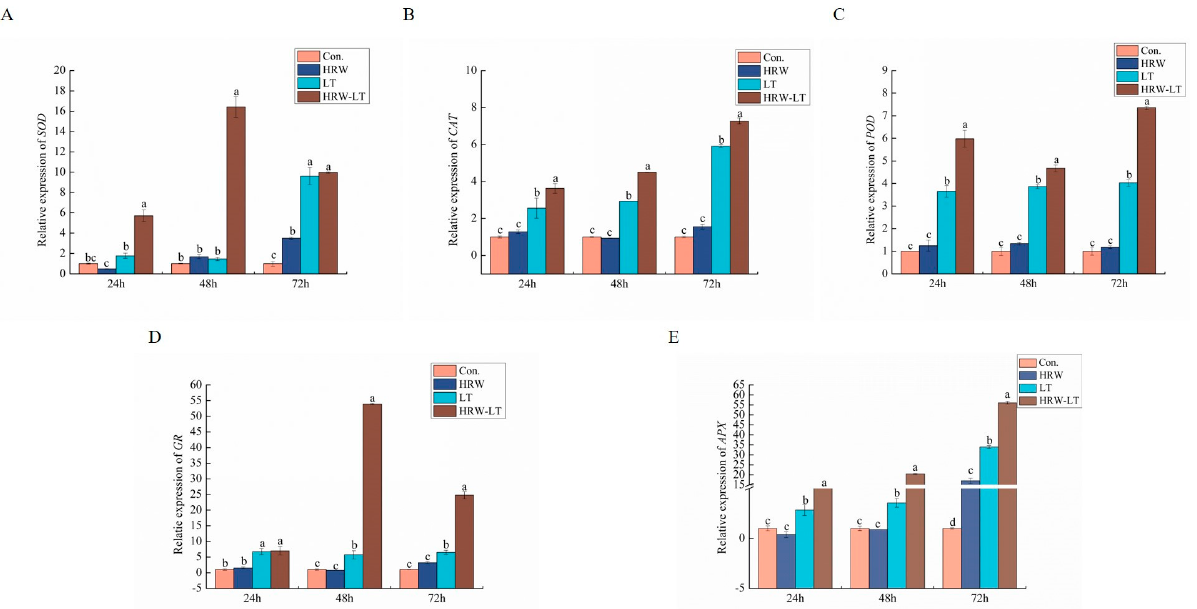
Figure 12. Effect of HRW on antioxidant-related enzyme gene expression in cucumber seedlings under chilling stress. ( A ) SOD ; ( B ) CAT ; ( C ) POD ; ( D ) GR ; ( E ) APX . Data are the mean ± standard deviation of three biological replicates. The different letters indicate a significant difference ( p < 0.05).